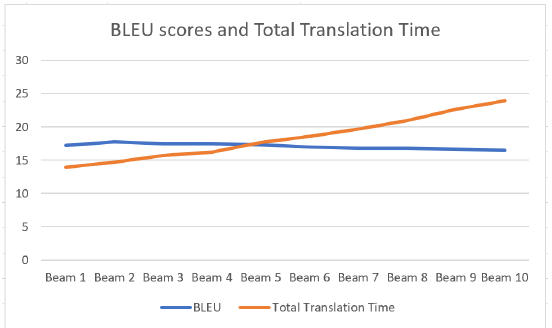
Figure 3. Graph of BLEU scores and translation